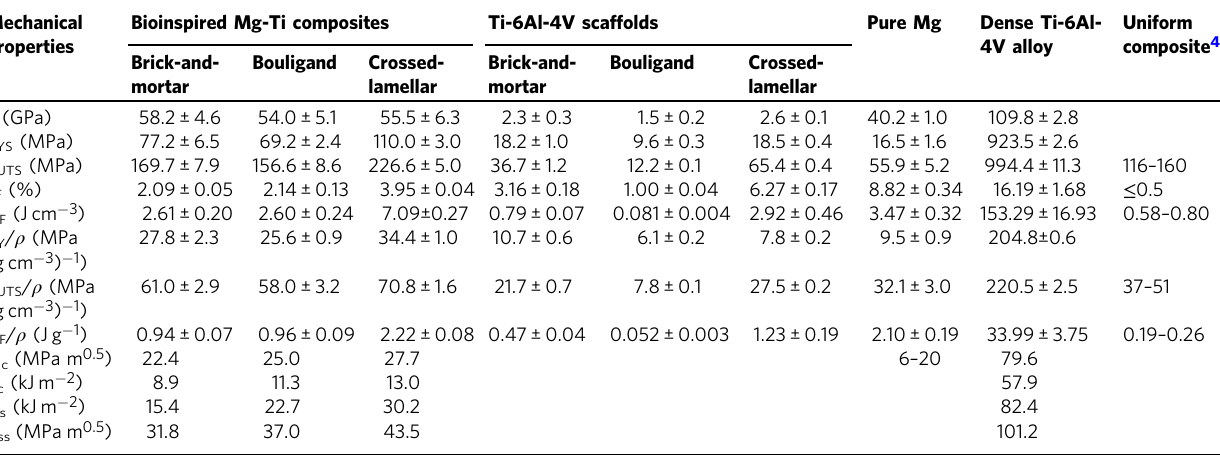
Table 1 Mechanical properties of bioinspired Mg-Ti composites with different architectures. Mechanical